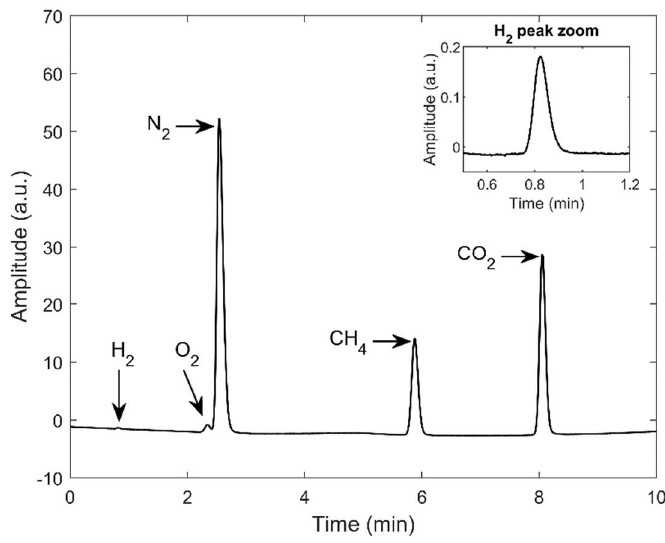
Figure 3. Example of GC–TCD measurement of a sample from the synthetic mixture B.